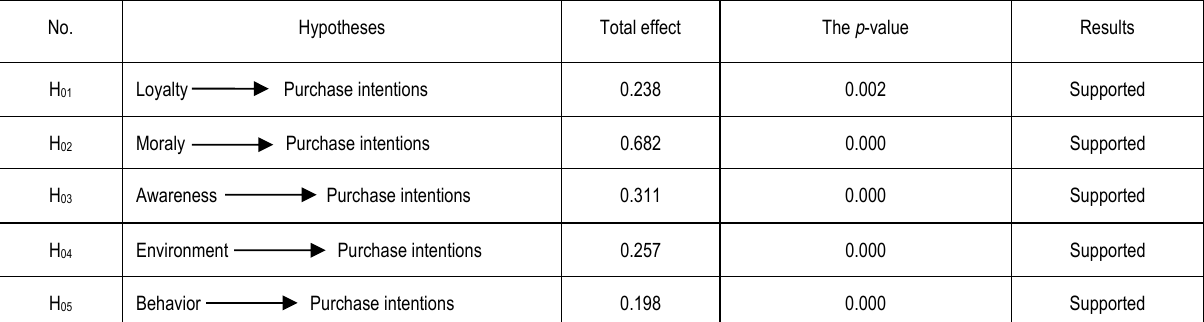
Table 5. Results of hypotheses